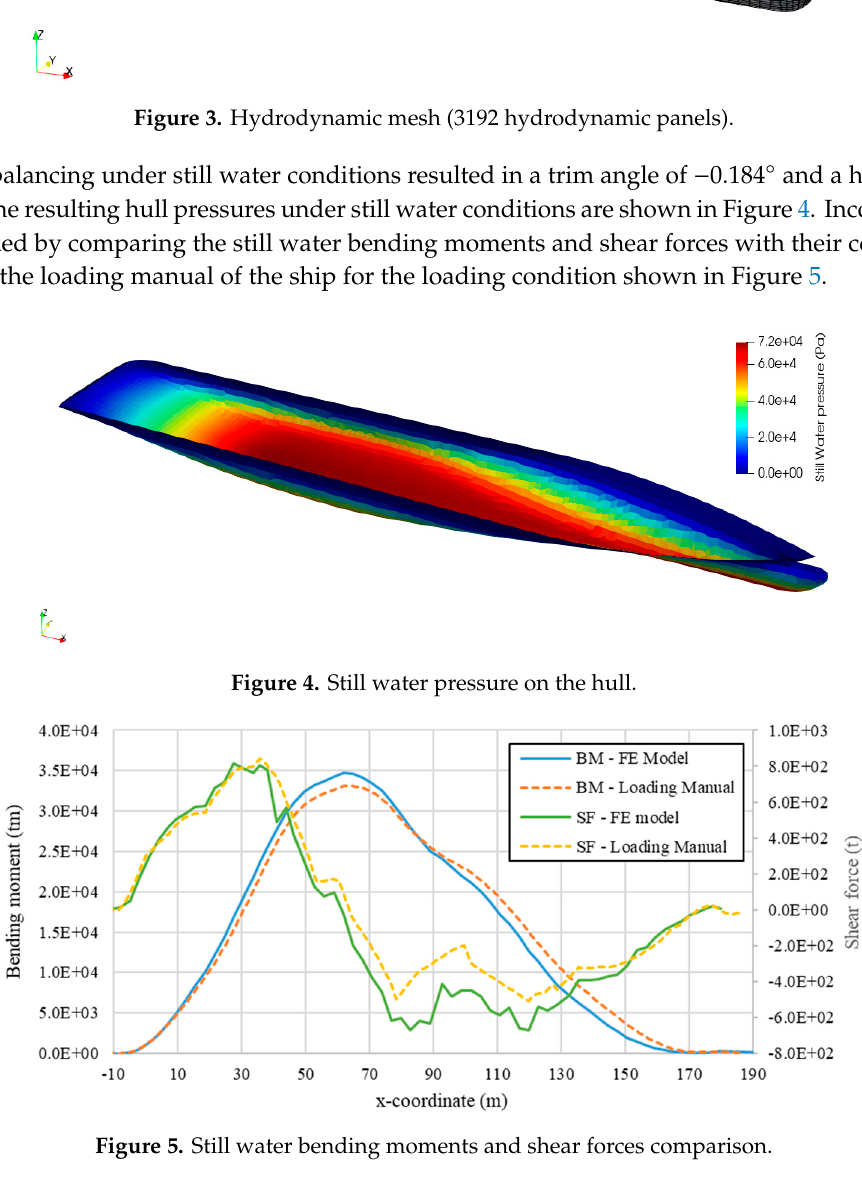
Figure 3. Hydrodynamic mesh (3192 hydrodynamic panels).